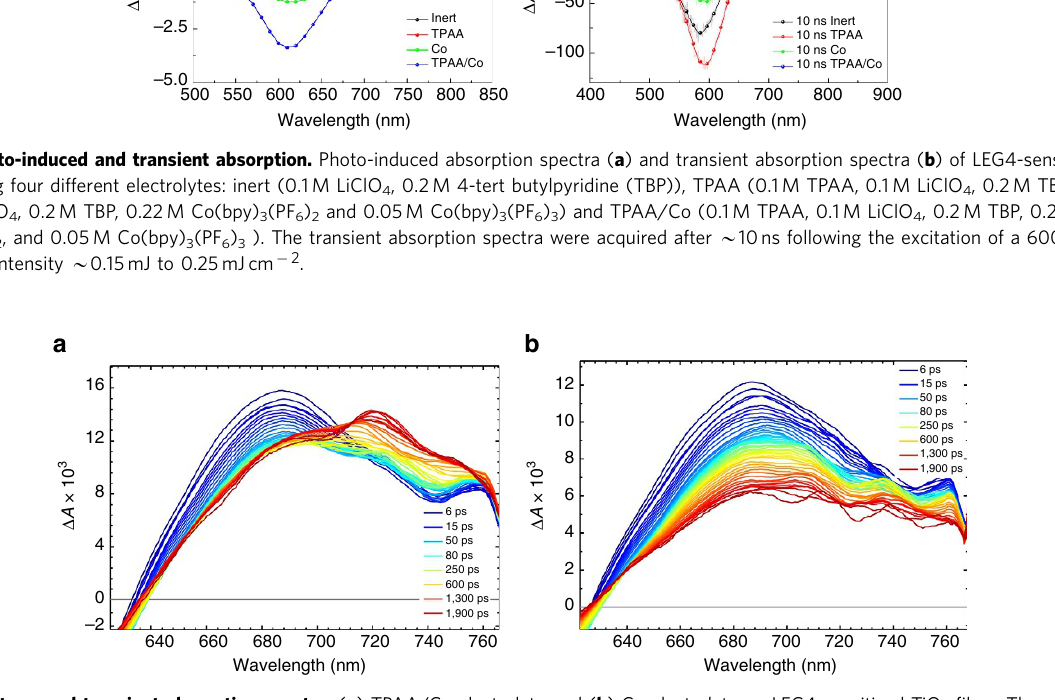
Figure 5 | Femtosecond transient absorption spectra. ( a ) TPAA/Co electrolyte and ( b ) Co electrolyte on LEG4 sensitized TiO 2 films. The excitation wavelength is 525nm with an intensity of 500nJ per